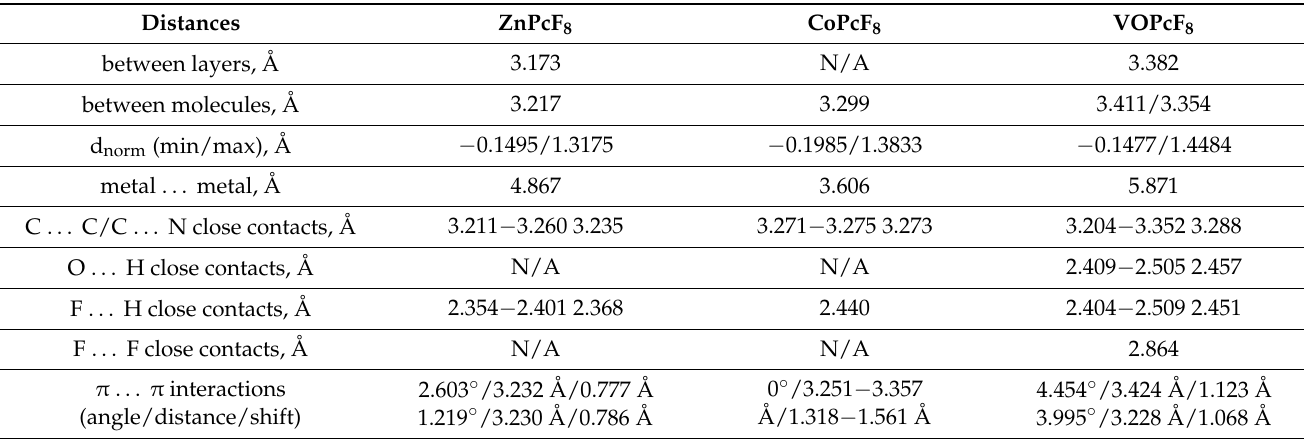
Table 2. Intermolecular and interatomic distances in MPcF 8